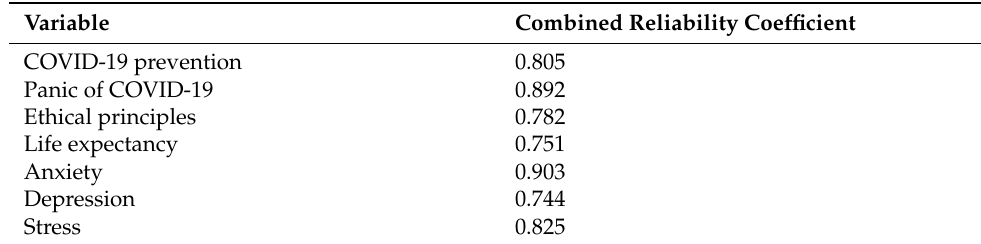
Table 1. The combined reliability of research model variables.